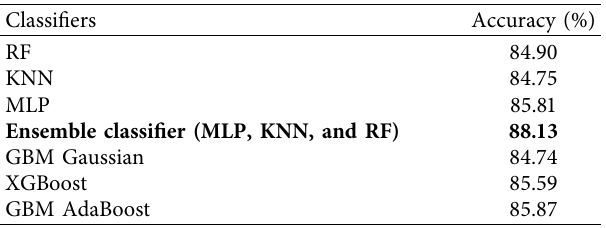
Table 8: Classification results using top 10 features selected by Information